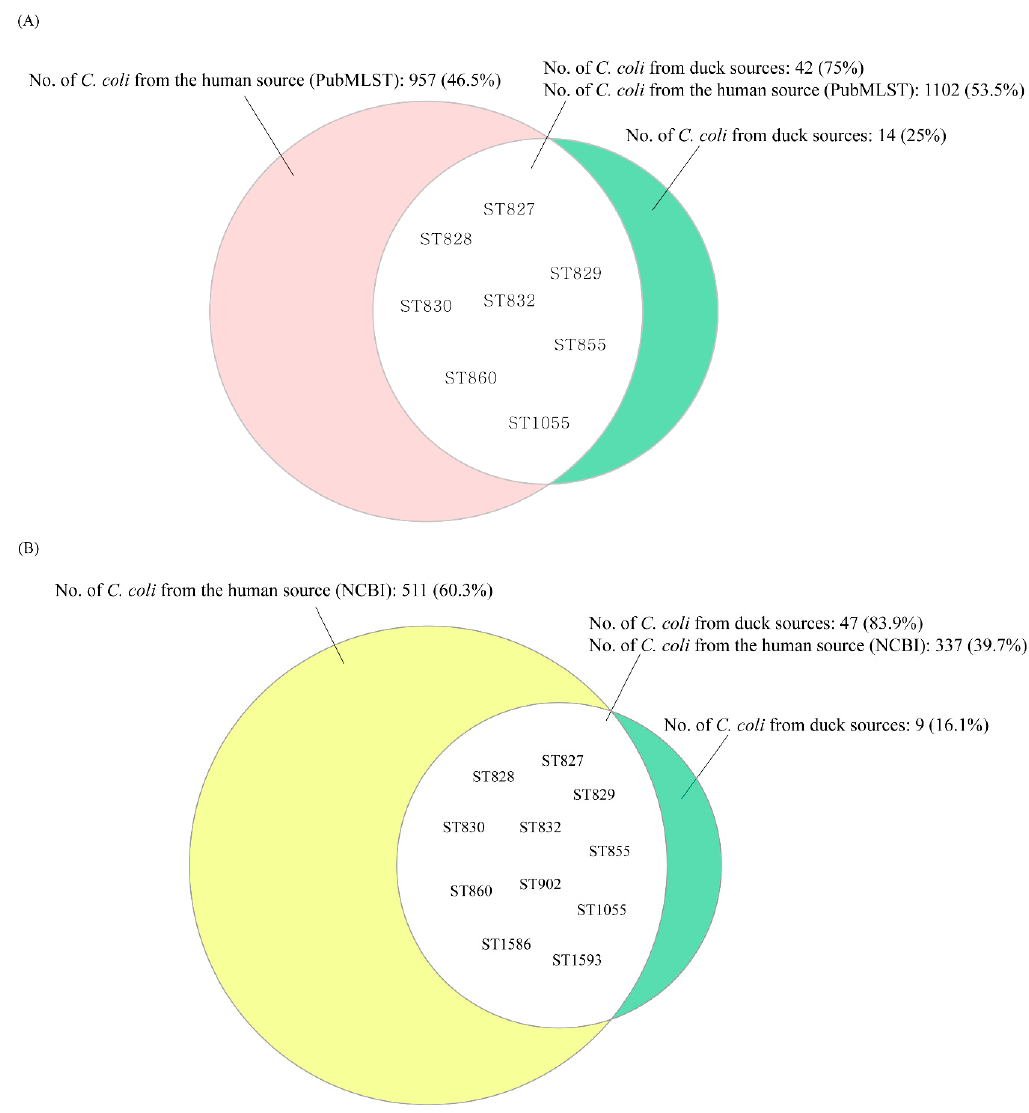
Figure 4. The proportion of C. coli isolates belonging to multi-locus sequence typing (MLST) sequence types (STs) shared between duck sources and the human source in ( A ) PubMLST and ( B ) NCBI. ( A ) The proportion of C. coli isolates belonging to MLST STs shared between the duck sources and human source (PubMLST). The proportions of C. coli isolates that belonged to the shared MLST STs were 75% and 53.5% in duck sources and the human source (PubMLST), respectively. The green section indicates the proportion of duck-derived C. coli belonging to the non-shared STs. The red section indicates the proportion of human-derived C. coli isolates belonging to the non-shared STs. The intersection (white) represents the proportion of C. coli isolates belonging to the eight MLST STs (ST827, ST828, ST829, ST830, ST832, ST855, ST860, and ST1055) shared between the duck sources and human source (PubMLST). ( B ) The proportion of C. coli isolates belonging to MLST STs shared between duck sources and the human source (NCBI). The proportions of C. coli isolates that belonged to the shared MLST STs were 83.9% and 39.7% in the duck sources and human source (NCBI), respectively. The green section indicates the proportion of duck-derived C. coli belonging to non-shared STs. The yellow section indicates the proportion of human-derived C. coli isolates belonging to non-shared STs. The intersection (white) represents the proportion of C. coli isolates belonging to the 11 MLST STs (ST827, ST828, ST829, ST830, ST832, ST855, ST860, ST902, ST1055, ST1586, and ST1593) shared between the duck sources and human source